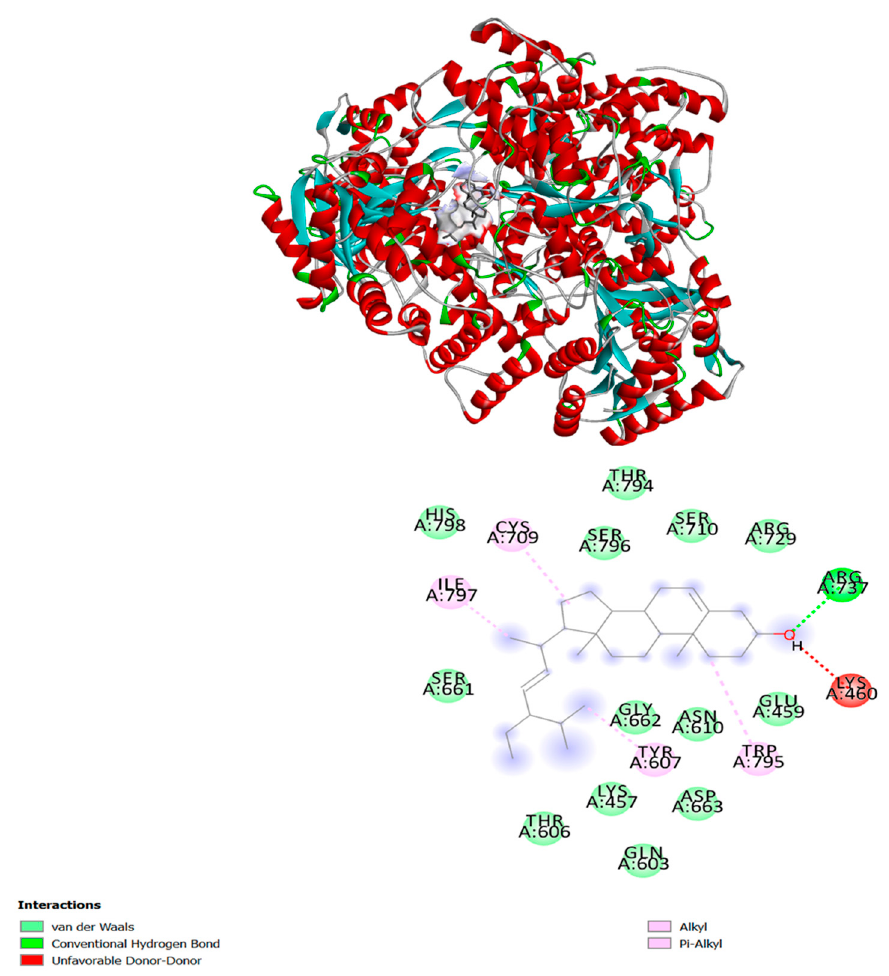
Figure 4. Molecular interaction of stigmasterol with DENV RdRP domain. The different types of interaction are indicated by different colors. The interactions are visualized and analyzed via BIOVIA Discovery Studio 2020.